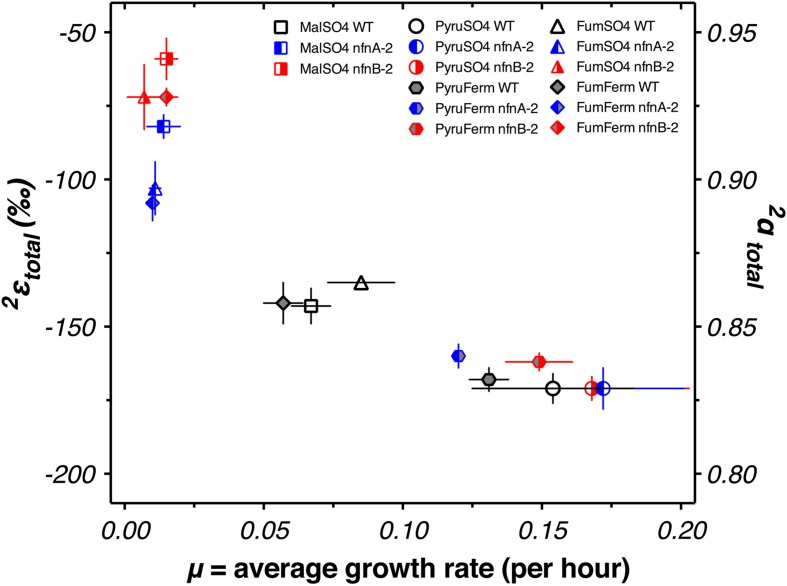
Average weighted growth rate (μ) versus the 2εtotal for all experiments.